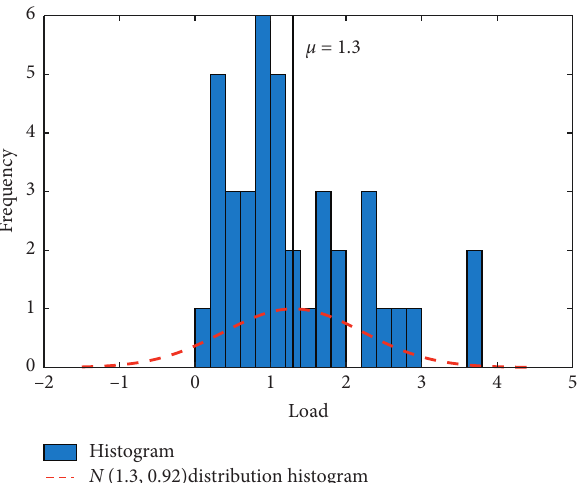
Figure 12: Histogram of horizontal load